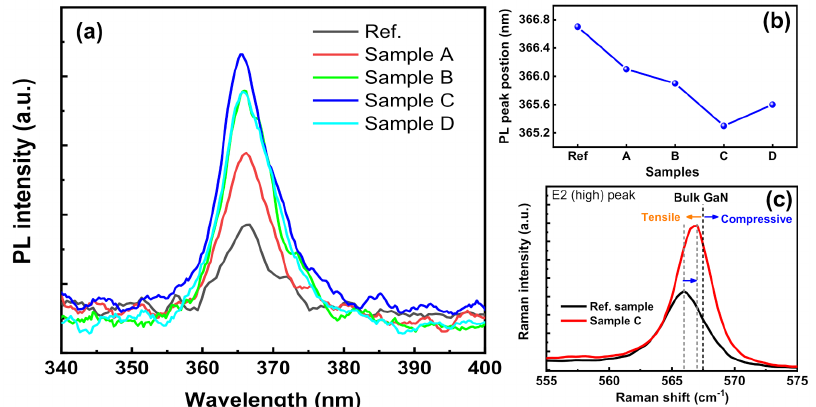
Figure 4. ( a ) Photoluminescence (PL) intensity and ( b ) PL peak position of all the studied samples. ( c ) Raman spectra of the reference sample and sample C.